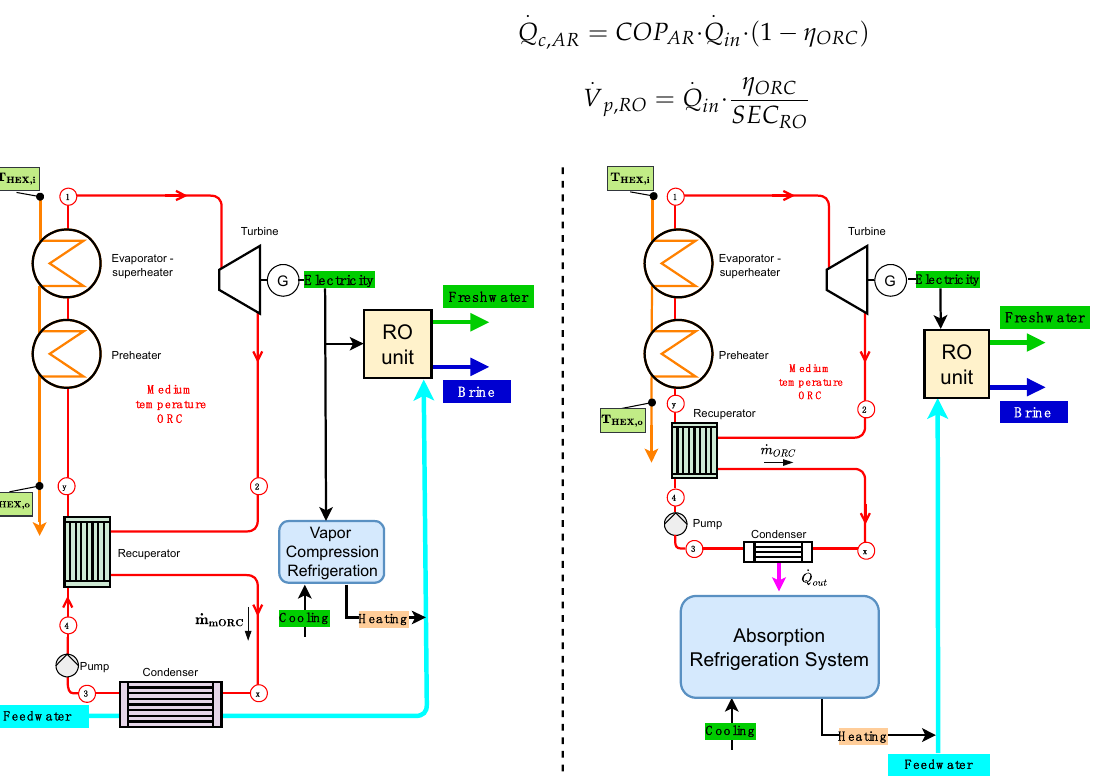
Figure 11. Configurations considered to be compared: CSP − ORC + (RO + VC) ( left ) and CSP − ORC + (RO + ARS) ( right ). Table 4. Comparison of the CSP − ORC configuration for desalination (same desalination capacity).